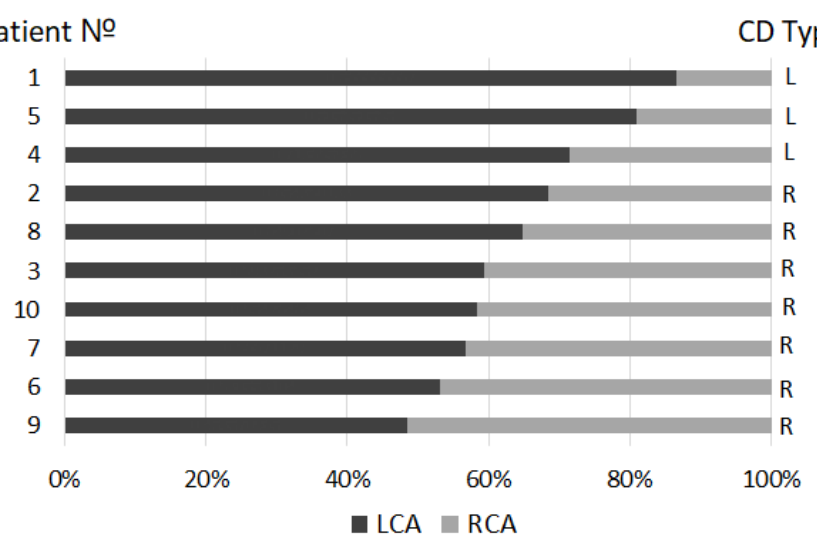
Figure 3. The fraction of CBF in LCA and RCA for all patients, which was calculated for full trees by the recursive algorithm under nonhyperemic (normal) conditions. CD—coronary dominance: R—right dominant type, L—left dominant type. Patients (on the left) are arranged from the largest proportion of LCA blood flow to the smallest. For exact values see Table